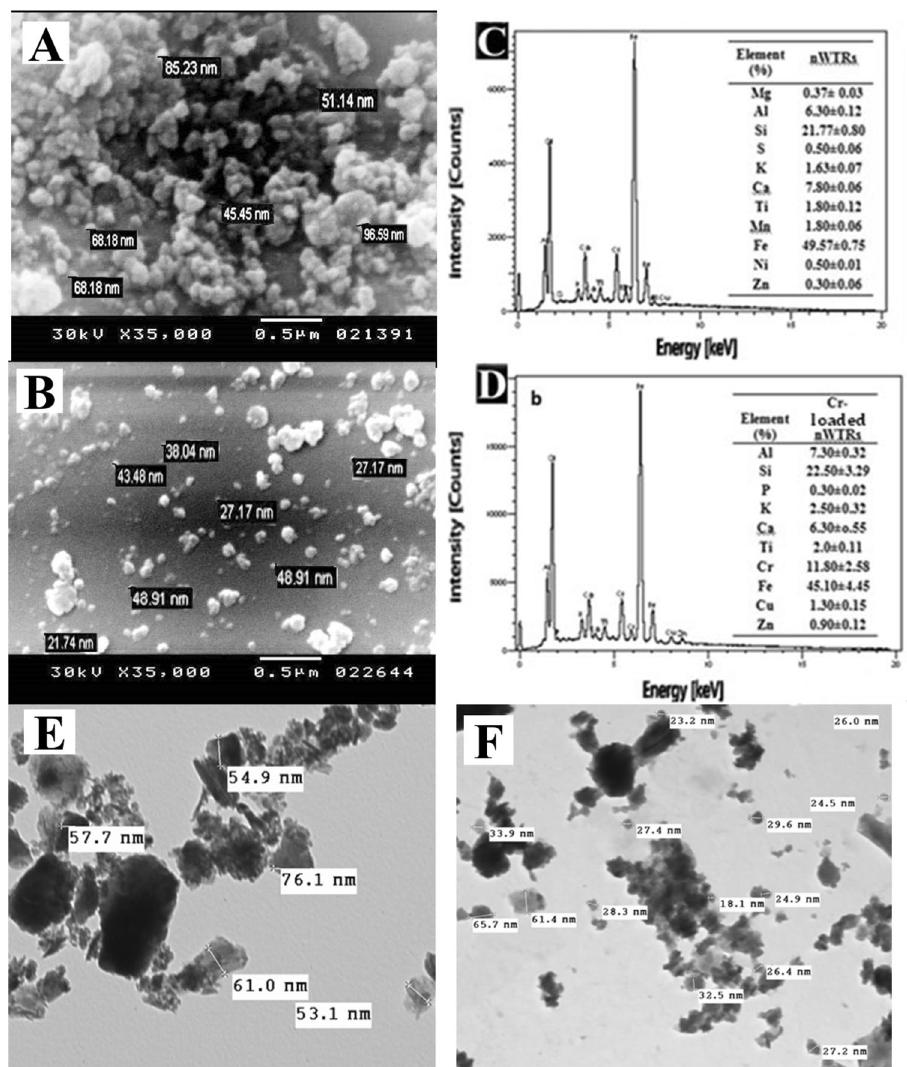
Figure 1. Scanning electron microscopy (SEM) image and energy dispersive X-ray (EDX) elemental distribution of nWTRs ( A – C ), the Cr(VI)—loaded nWTRs ( B – D ), Transmission electron microscopy (TEM) image of nWTRs ( E ) and Cr(VI)—loaded nWTRs ( F